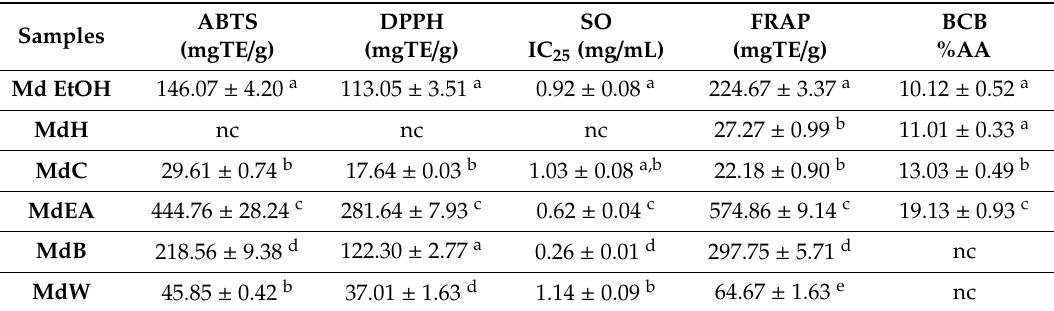
Figure 2. Total Polyphenol Content (TPC) and Total Terpenoid Content (TTeC) of M. di ff usa fractionated samples. Results are expressed as mean ± standard deviation of triplicate determinations in ‘mg of Gallic Acid Equivalents per gram’ (mg GAE / g) of dried sample and in ‘mg of Linalool Equivalents per gram’ (mg LE / g) of dried sample. In each test, the values with the same letter (a, b, c, d, e) are not significantly di ff erent at the 95% confidence limit according to one-way analysis of variance (ANOVA). Samples are crude ethanol extract (Md EtOH), n -hexane fraction (MdH), chloroform fraction (MdC), ethyl acetate fraction (MdEA), n -butanol fraction (MdB) and water fraction (MdW). Table 1. Results of 2,2 (cid:48) -azino-bis(3-ethylbenzothiazoline-6-sulfonic acid) (ABTS), 2,2-diphenyl-1- picrylhydrazyl (DPPH) and Super Oxide anion (SO) scavenging activity, Ferric Reducing Antioxidant Power (FRAP) and β -Carotene Bleaching (BCB) of M. di ff usa